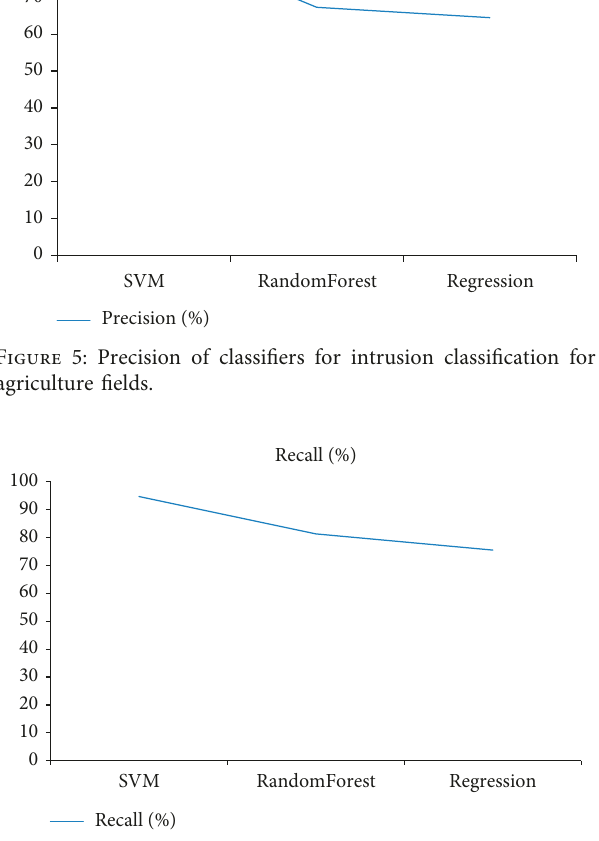
Figure 6: Recall of classifiers for intrusion classification for ag- riculture